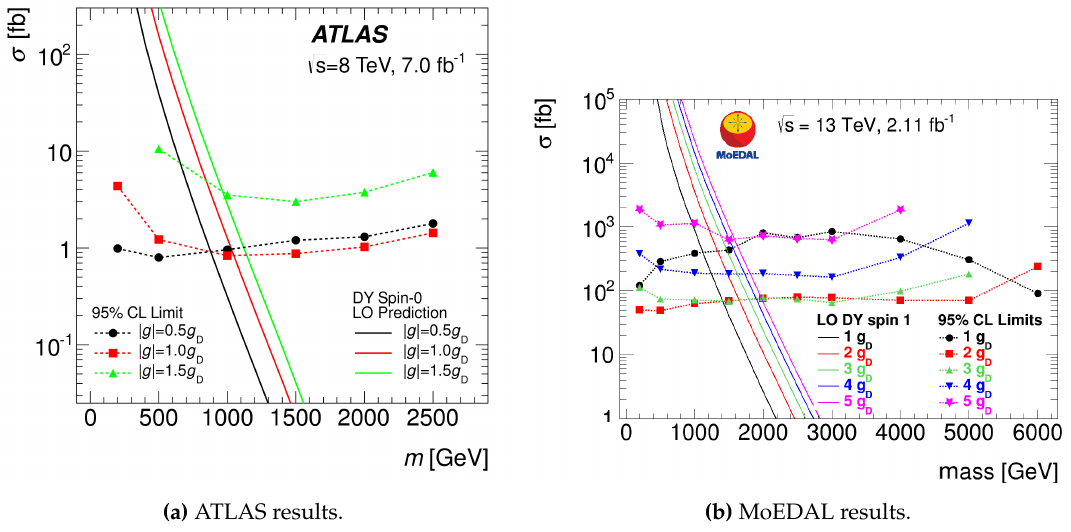
Figure 2. ( a ) 95% cross-section upper limits (dashed lines) and theoretical cross sections (solid lines) for magnetic monopoles with spin 0 and various magnetic charges—from Ref. [88]; ( b ) cross-section upper limits at 95% confidence level for DY monopole production as a function of mass for spin-1 monopoles. The various line colours correspond to different monopole charges. The solid lines represent DY cross-section calculations at leading order. From Ref.